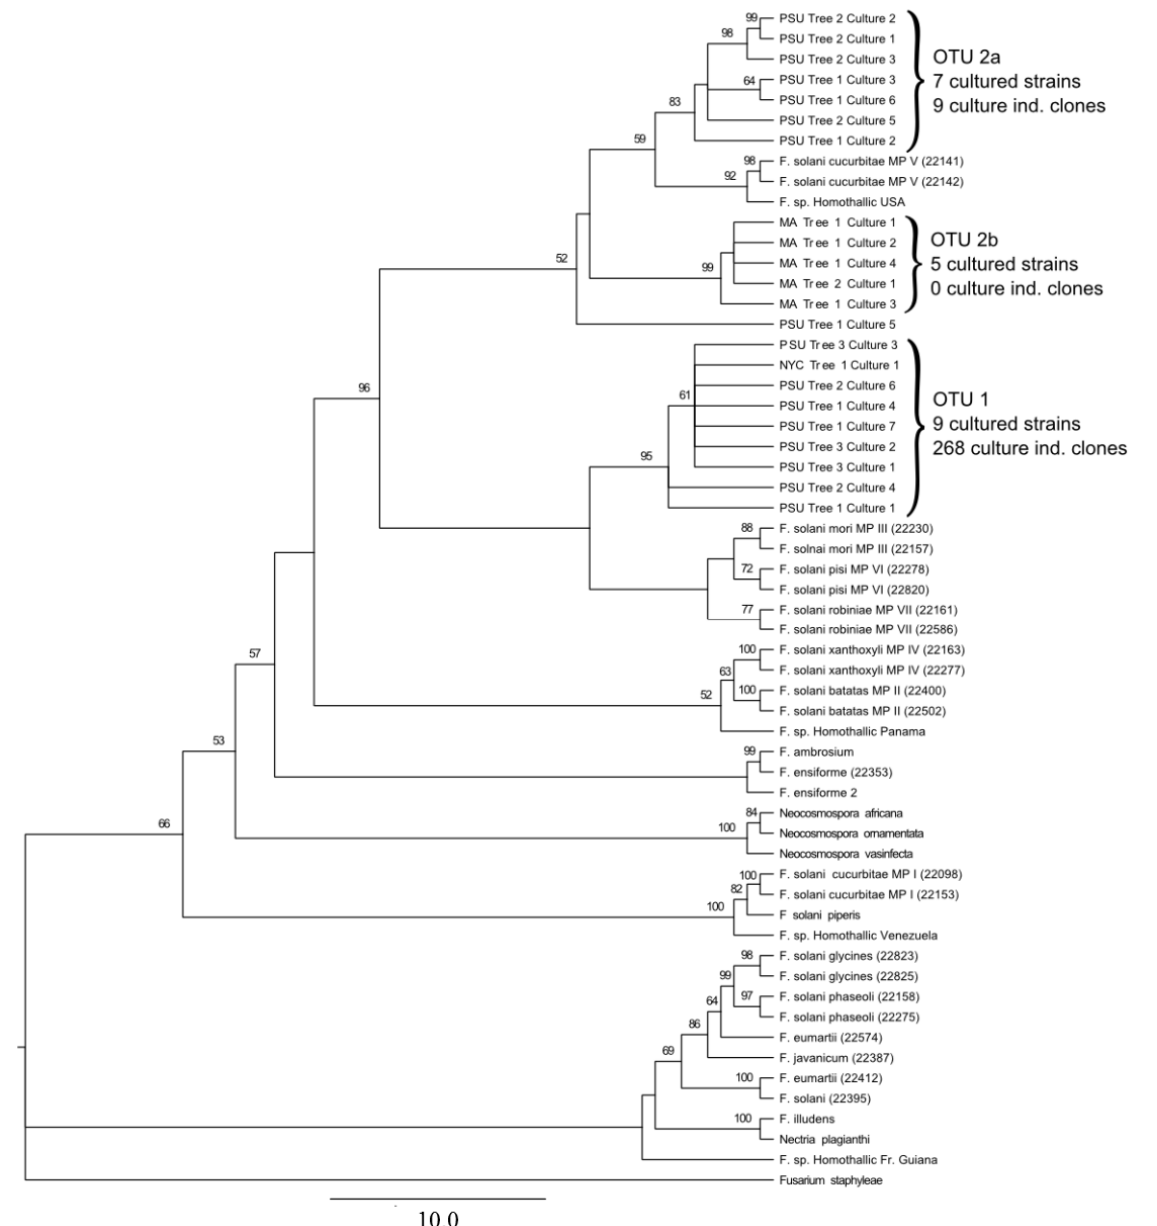
Figure 2. Multilocus phylogenetic analysis of ALB-derived and O’Donnell Fusarium solani isolates using the internal transcribed spacer region, the translation elongation factor 1-alpha locus, and the large ribosomal subunit locus. A rooted maximum likelihood tree was generated using a partitioned evolutionary model with sequences from three loci from all isolates cultured from ALB larvae (n = 500 bootstrap replicates). ALB-derived sequences were placed within the F. solani species complex, utilizing the dataset of O’Donnell [44]. Mating populations (abbreviated MP) are listed based off of the O’Donnell dataset. Nodes with bootstrap support values > 50 are reported, ML distance scale bar = 10 changes. ALB-derived isolates formed 3 strongly supported monophyletic clades, denoted as OTU1, OTU2a, and OTU2b. A single NYC isolate can be found in OTU1, while all MA-derived isolates were classified into OTU2b. PSU-derived isolates can be observed in both OTU1 and